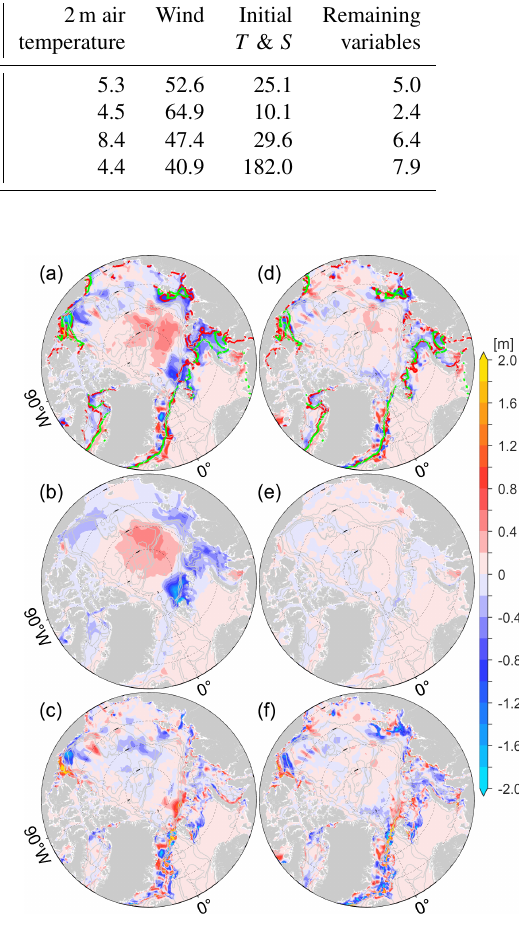
Figure 10. (a) Differences in (cid:82) d h integrated from 20 May to d t 15 June between adjoint-FD and the control run (adjoint-FD mi- nus the control run), attributed to (b) (cid:82) F ai and (c) (cid:82) F adv differ- ences. Panels (c) – (f) are the same as (a) – (c) but for adjoint-VP. The red and green lines in (a) and (d) indicate the model-simulated (a for adjoint-FD; d for adjoint-VP) and satellite-observed SIEs on 15